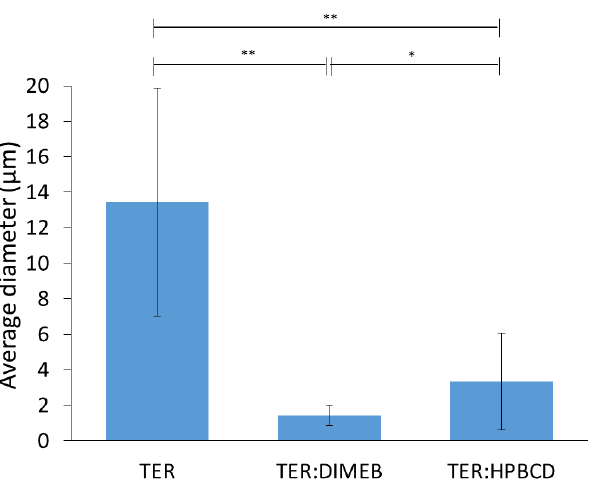
Figure 12. Average diameter and standard deviation of particles (** p < 0.01; * p < 0.05).